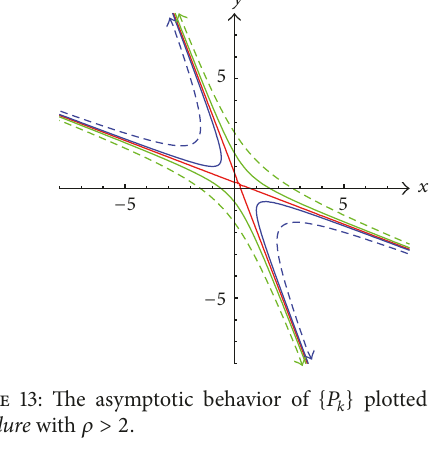
Figure 13: The asymptotic behavior of {𝑃 𝑘 } plotted by Tracking Procedure with 𝜌 > 2 .